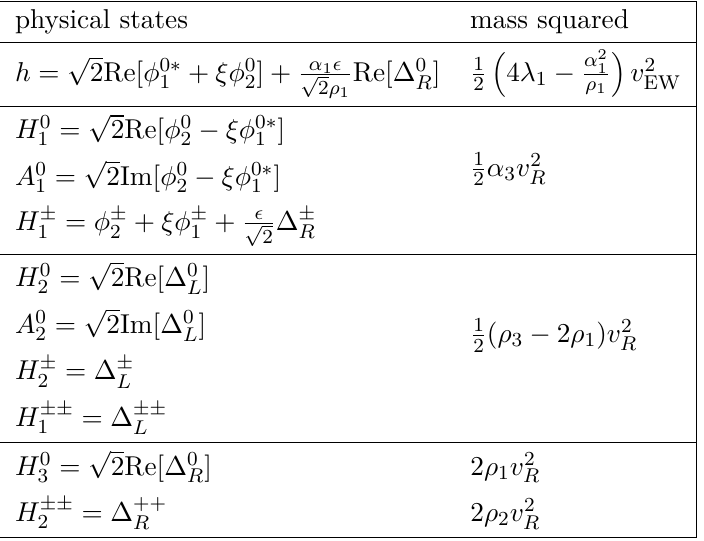
Table 5 . Physical Higgs states and their masses when v L (cid:28) κ 2 (cid:28) κ 1 (cid:28) v R [143]. Here ξ = κ 2 /κ 1 (cid:15) = v EW /v R ’ κ 1 /v R . h is the SM Higgs field. while for the singly-charged gauge bosons, in the basis of { W ± matrix